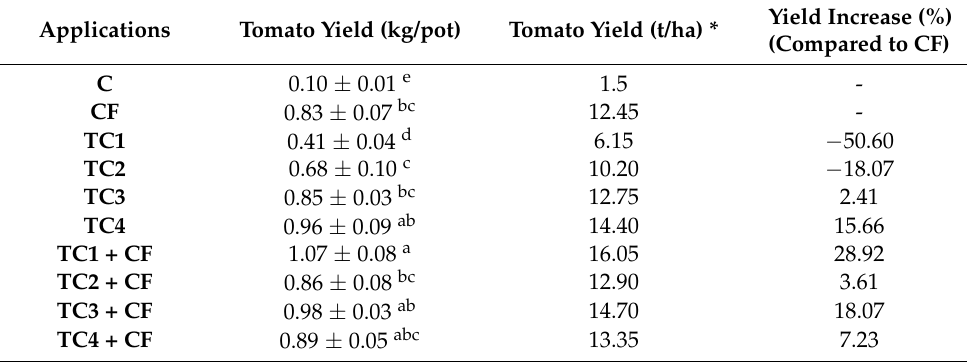
Table 3. Effect of tomato compost on total tomato